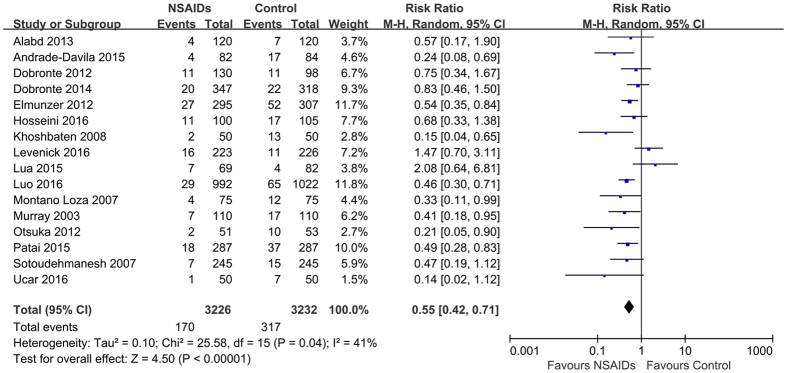
Forest plot showing a significant reduction in the risk of any post-ERCP pancreatitis with rectal NSAIDs therapy.CI, confidence interval; M-H, Mantel-Haenszel; NSAIDs, nonsteroidal anti-inflammatory drugs; ERCP, endoscopic retrograde cholangiopancreatography.